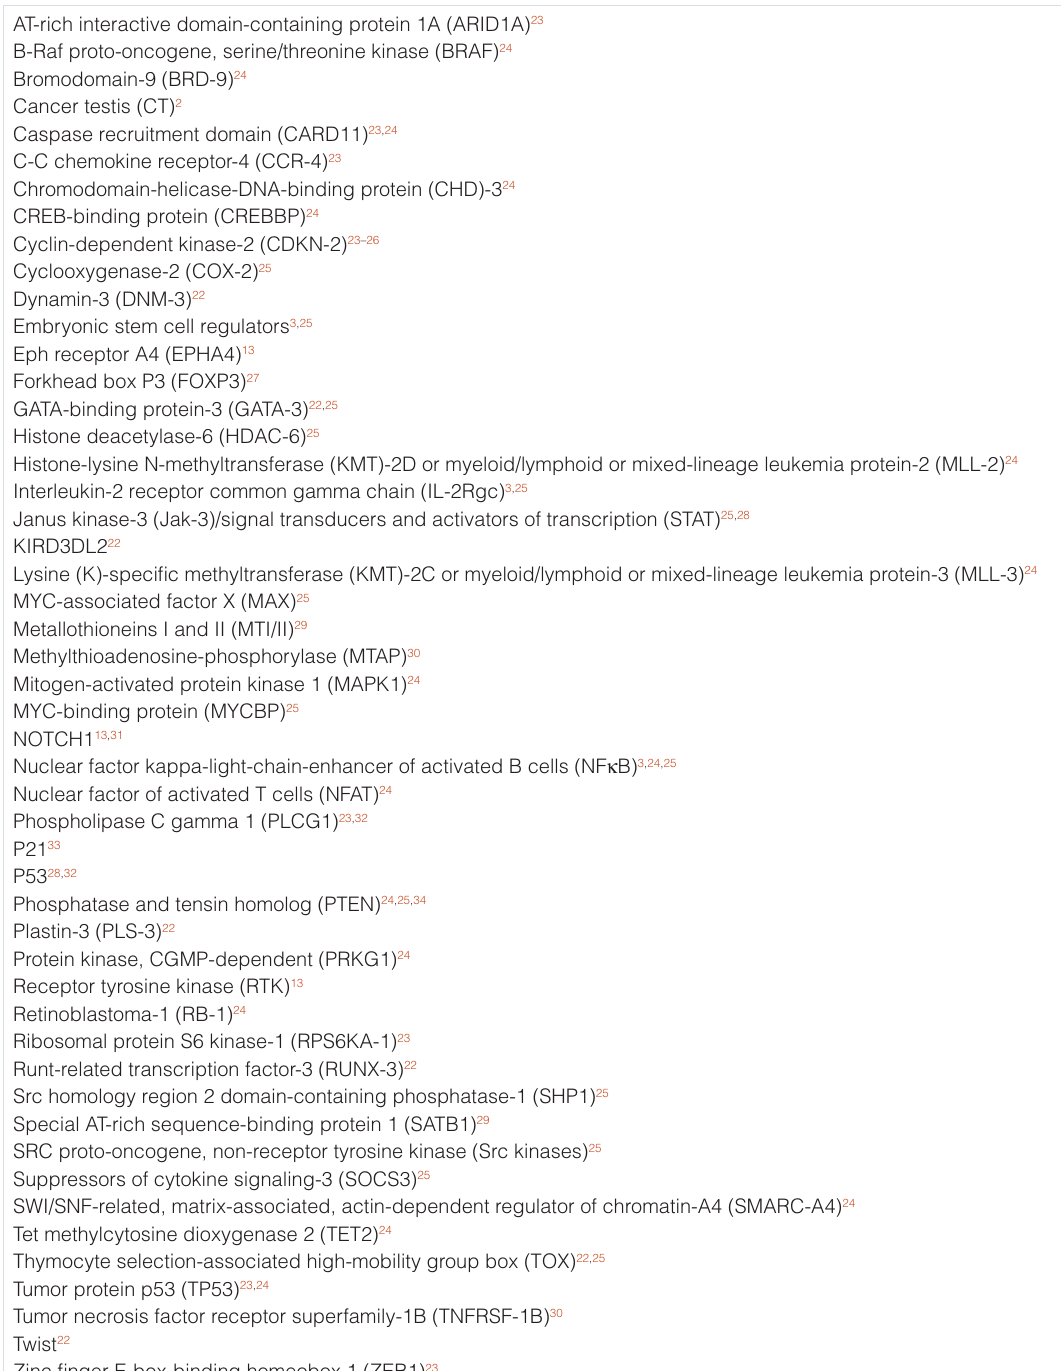
Table 2. An alphabetical list of dysregulation of genes and signaling pathways seen in the cutaneous T cell lymphomas. AT-rich interactive domain-containing protein 1A (ARID1A) 23 B-Raf proto-oncogene, serine/threonine kinase (BRAF)